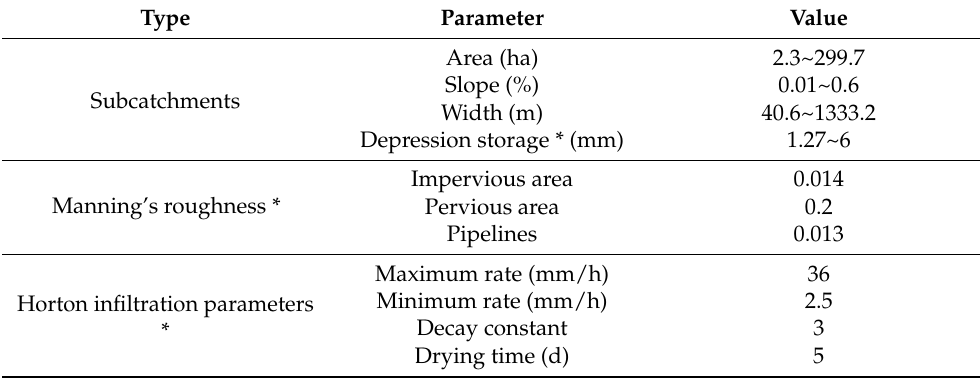
Figure 5. Observed and simulated water depths of the two historical rainfall events: ( a ) 16th August 2009; ( b ) 1st August 2012. Table 2. The parameters of the coupled